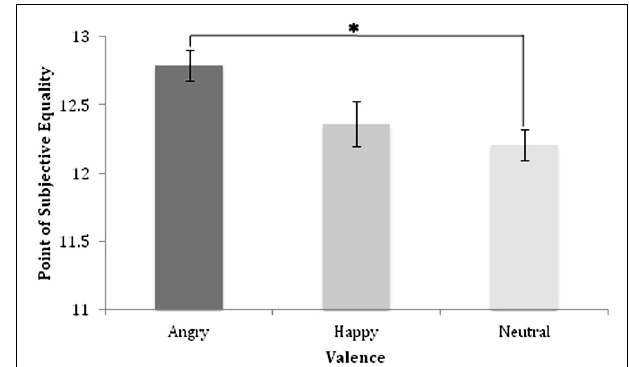
FIGURE 2 | Point of subjective equality and standard error values for each